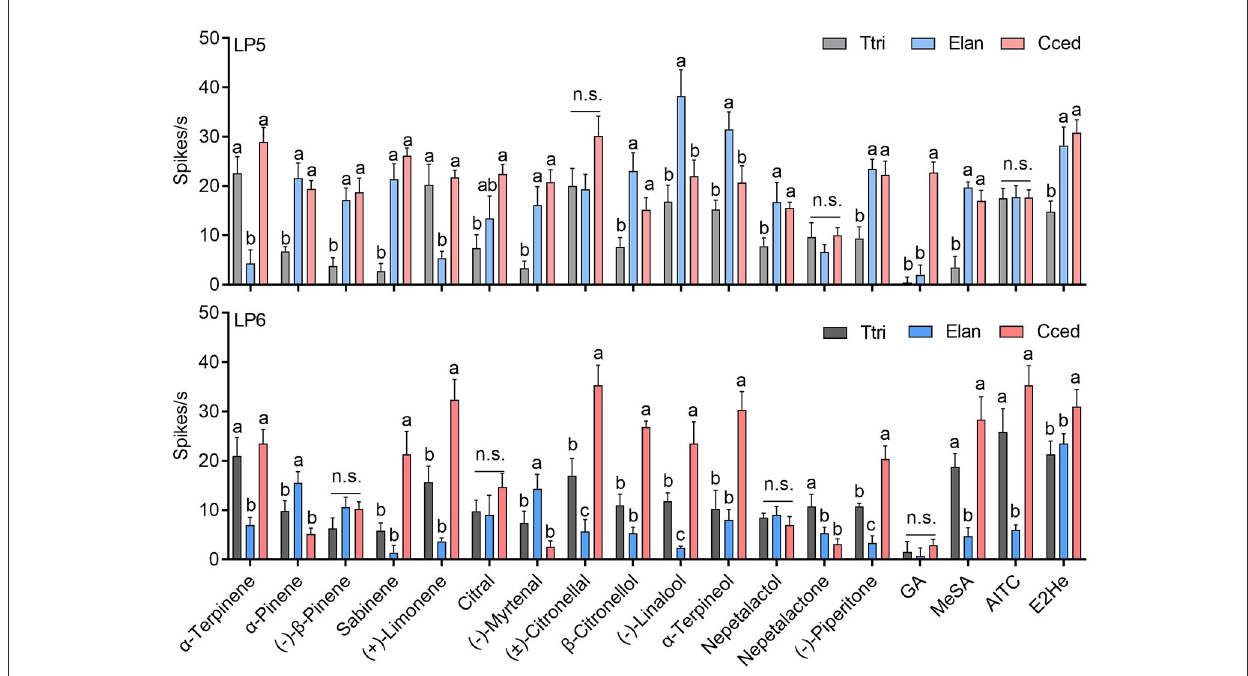
FIGURE8 Comparison of the neuronal response values between LP5 and LP6 among C. cedri , E. lanigerum , and T. trifolii to the tested odorants. Bars labeled with different letters are significantly different; n.s. indicates no significant differences (mean ± SEM, n = 3–13, GLM followed by Duncan’s multiple range test). E2He, trans -2-hexenal; MeSA, methyl salicylate; AITC, allyl isothiocyanate; GA, geranyl